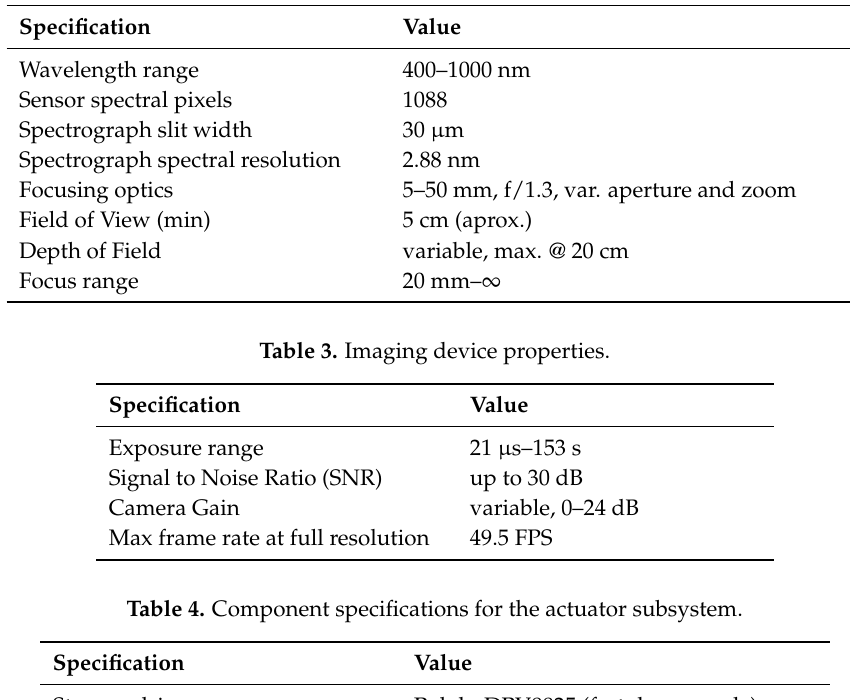
Figure 2. General schematic of the imaging prototype. ( A ) Overview and main components. ( B ) Closeup of the scanning mirror system. Spectra from a single line is read in a single shot, and then the scanning mirror allows for the capture of a full Field of View (FOV). Table 2. Component specifications for the optical subsystem.